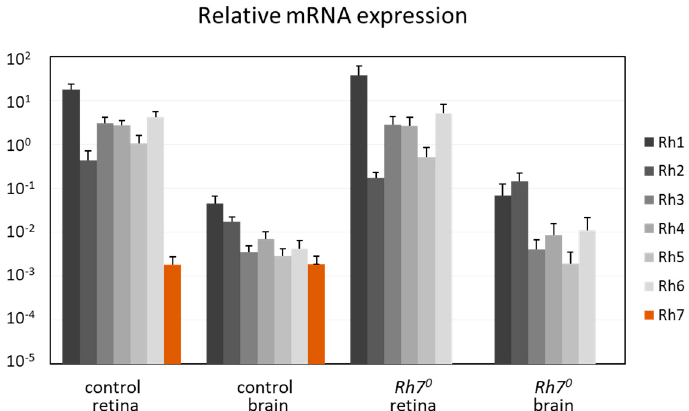
Figure 4. qPCR: Relative mRNA expression of all Rhodopsins in comparison to α -tubulin, in the brains and in retina of the control and the Rh7 0 mutant flies. All Rhodopsins were expressed in the brain and in the retina. Rh1 to Rh6 were highly expressed in the retina, but were about 100 times weaker in the brain. Rh7 was weakly, but equivalently expressed in the brain and in the